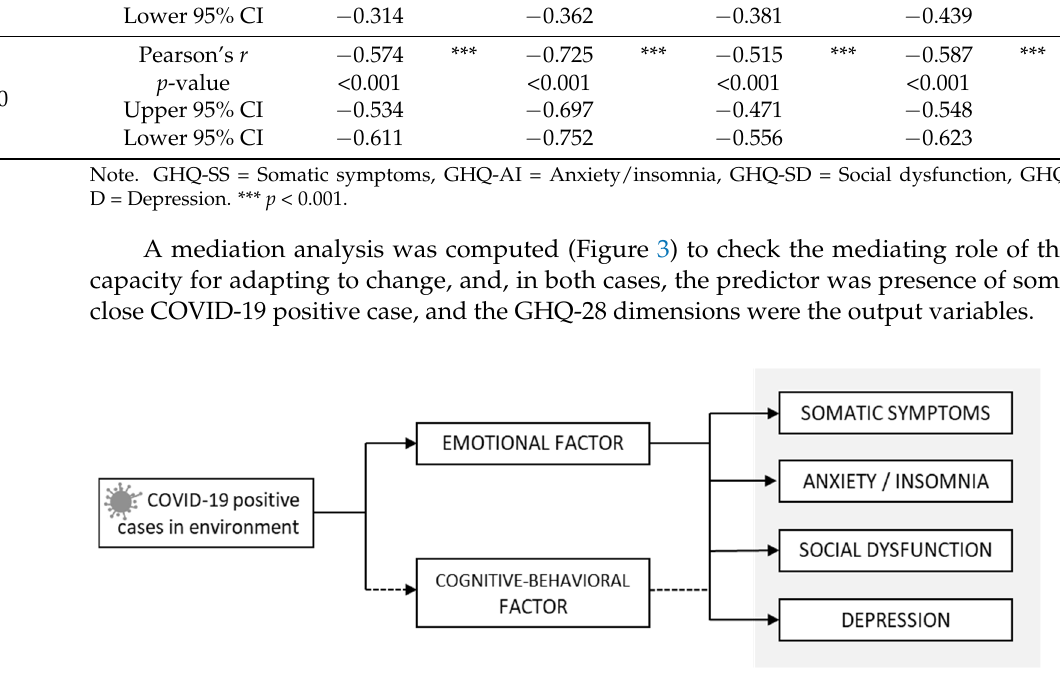
Figure 3. Hypothesized mediation model.